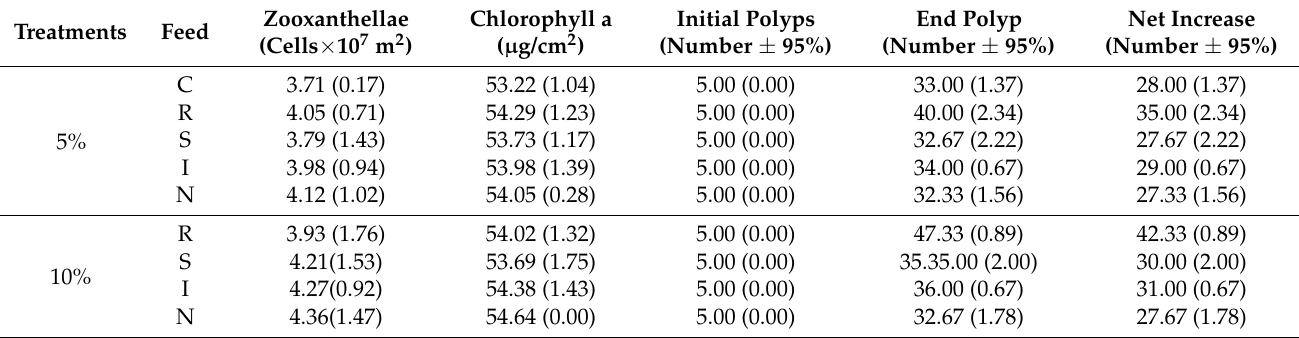
Table 4. Polyp number, zooxanthellae density, and chlorophyll a concentration of G. columna after 8 weeks of daily feeding. Treatments